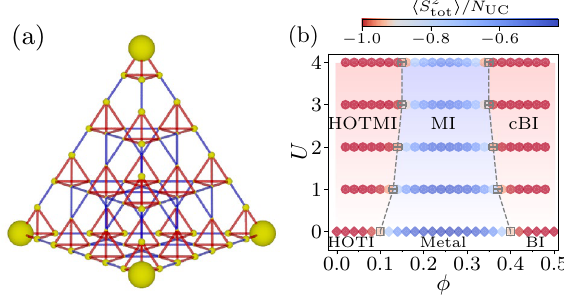
Figure 1. ( a ) Pyrochlore lattice for L = 4 with the open boundary conditions. The small upward tetrahedron represents the unit cell. Transfer integral for the intra (inter) unit cell indicated by red (blue) is t (cid:31) ( t (cid:31) ). Enhancement of the local moment by the on-site interaction U = 1 , i.e., � m 2 i � U = 1 − � m 2 i � U = 0 , is shown by the radius of the yellow spheres for φ = 0.08 and T = 0.08 . ( b ) Ground-state phase diagram as function of φ and U . The color of the two symbols, circles for U > 0 and diamonds at U = 0 , represents the value of (cid:31) S